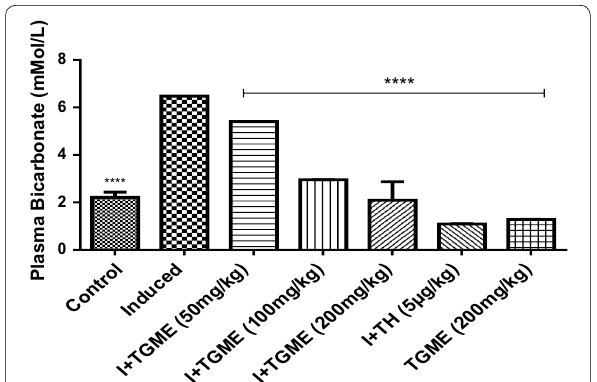
Fig. 9 Effect of aqueous methanolic leaf extract of Triclisia gilletii on protein carbonyl concentration in animals administered SEM of 6 rats ± ethane-1,2-diol. Data are expressed as mean ( n 6); **** p < 0.0001; *denotes that data were compared with = ethane-1,2-diol; TGME Triclisia gilletii aqueous methanolic extract, TH tamsulosin hydrochloride